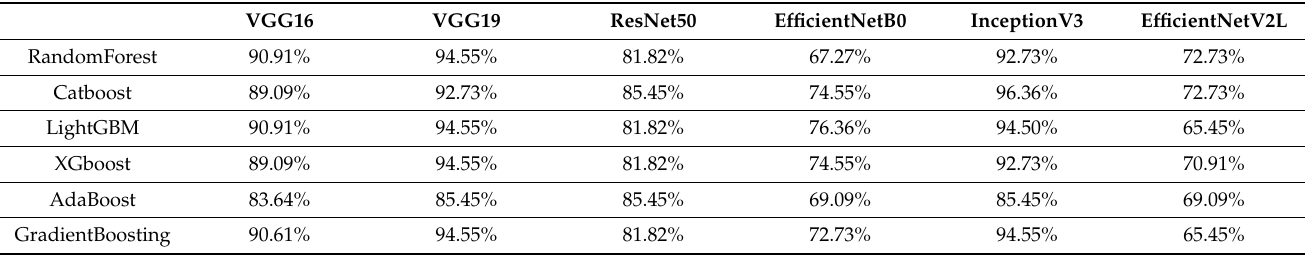
Table A19. Accuracy of each model combination for blue stars.